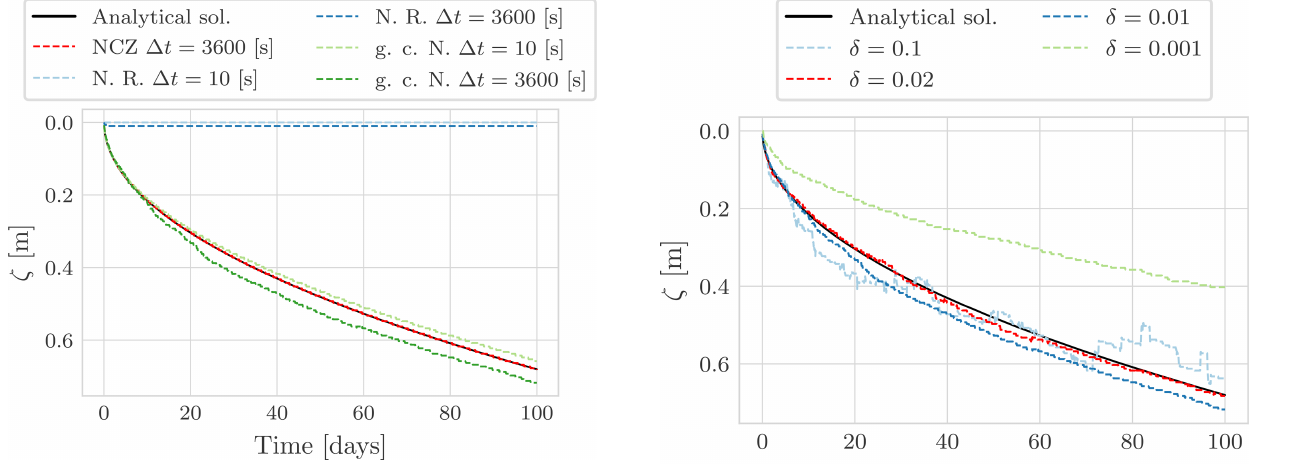
Figure 6. Comparison between the Neumann analytical solution and the numerical solution obtained with the Newton–Raphson (N. R.), globally convergent Newton (g. c. N.), and NCZ algorithms. All the numerical simulations use the same spatial discretization (cid:49)z = 0 . 005m.